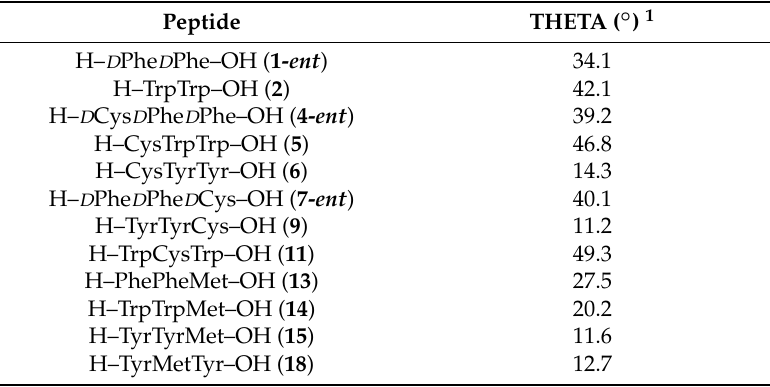
Table 2. Surface wettability of films formed by selected peptides.